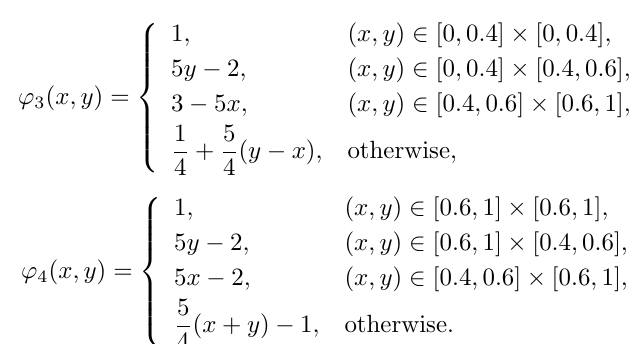
Figure 1. The sub-domains of Ω